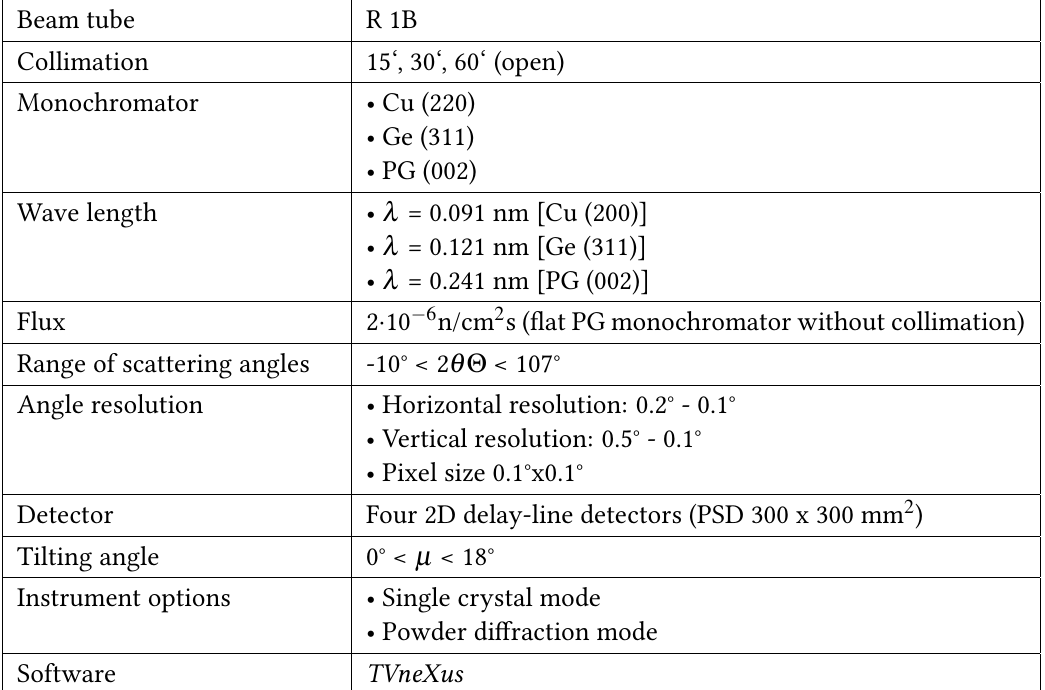
Table 1: Technical parameters of